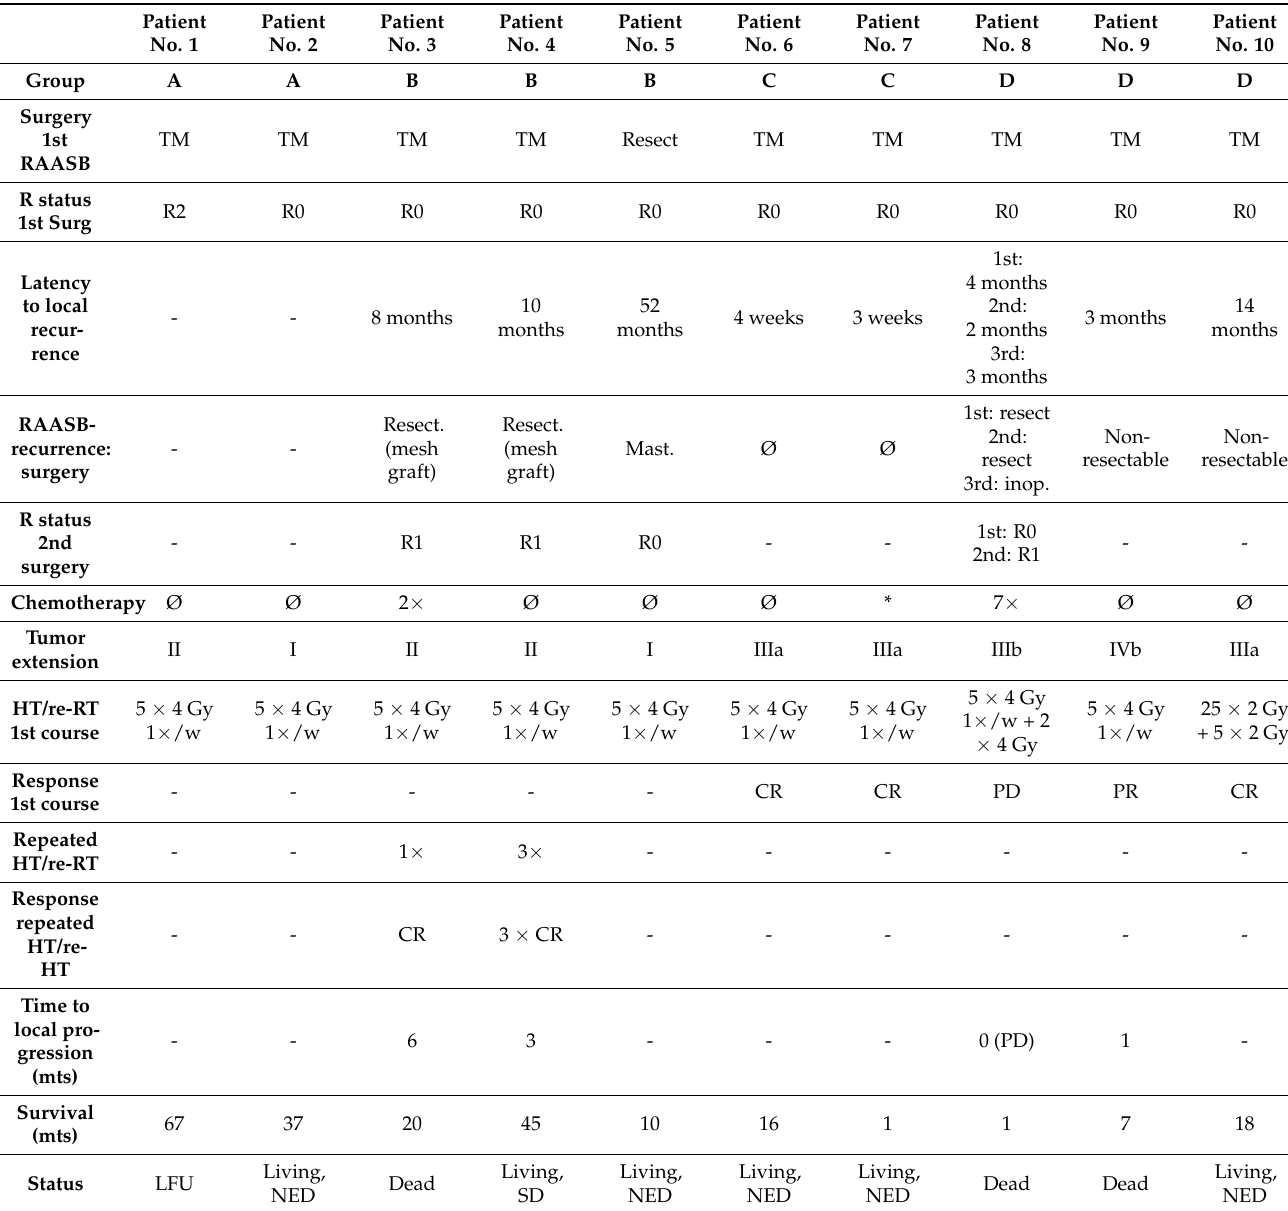
Table 3. Grouping of patients with RAASB and treatment